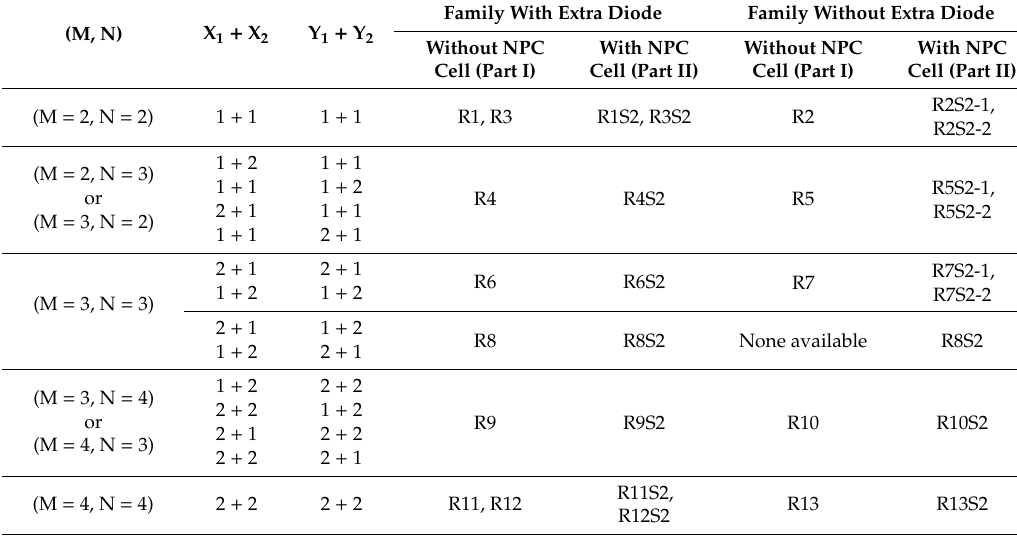
Table 2. Two inverter topology families from USPWM.